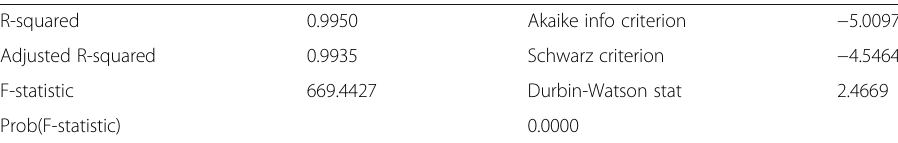
Table 7 Diagnostics Test